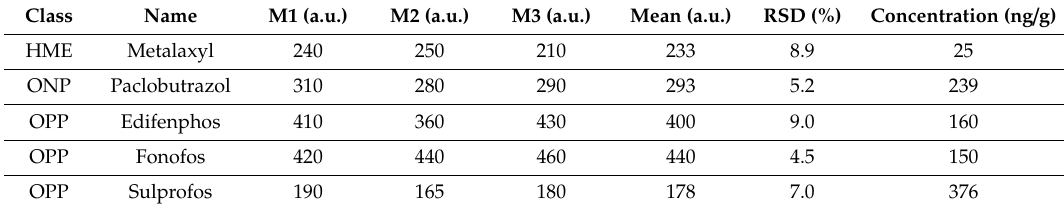
Table 2. Hits of plant protection compounds in the used co ff ee sample with values of peak height (a.u.) from three replicates, average, relative standard derivation (RSD), and the final concentration in 1 g of the coffee beans.